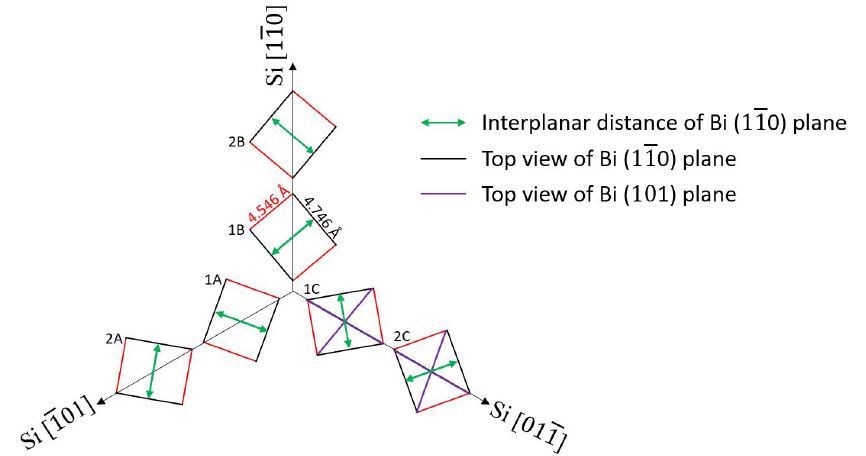
Figure 6. Scheme of six in-plane orientations of α -Bi in respect to Si (111) substrate <110> directions. Rectangles represent the (110) plane of bismuth unit cell laying on the Si (111) plane. From Figure 6, the origin of the observed pseudo-12-fold symmetry from Bi (110) planes becomes clearer. These perpendicular to surface planes are parallel to a